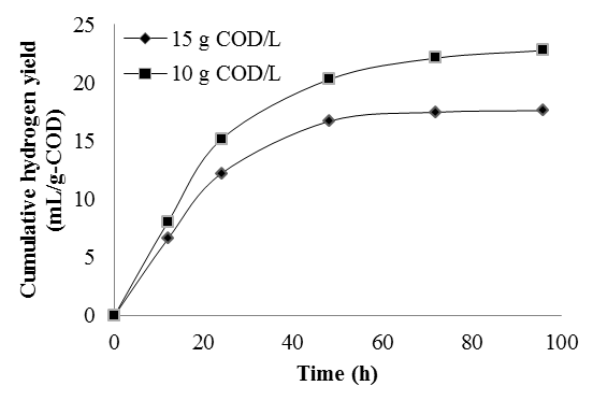
Fig. 2. Cumulative hydrogen yield at initial pH of 7 at two different substrate concentrations.